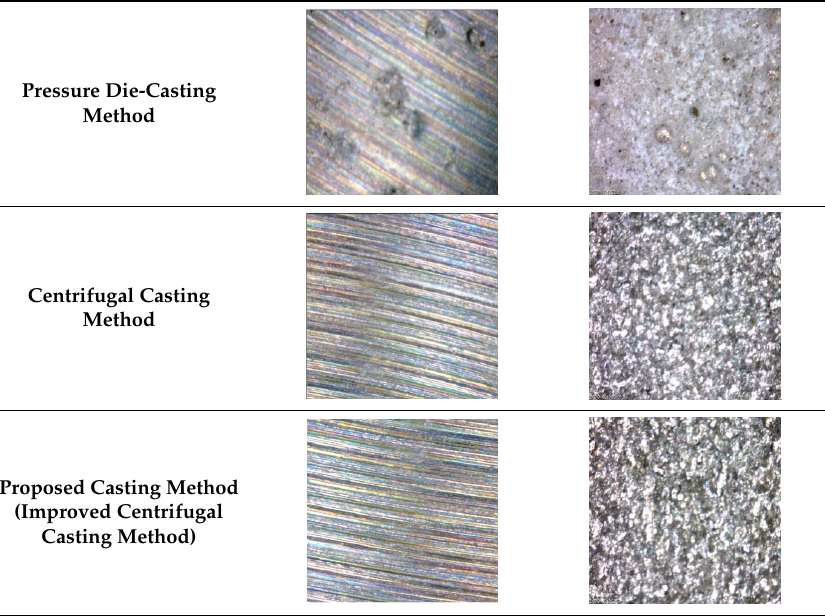
Table 3. The cutting plane and the texture state of the rotors.